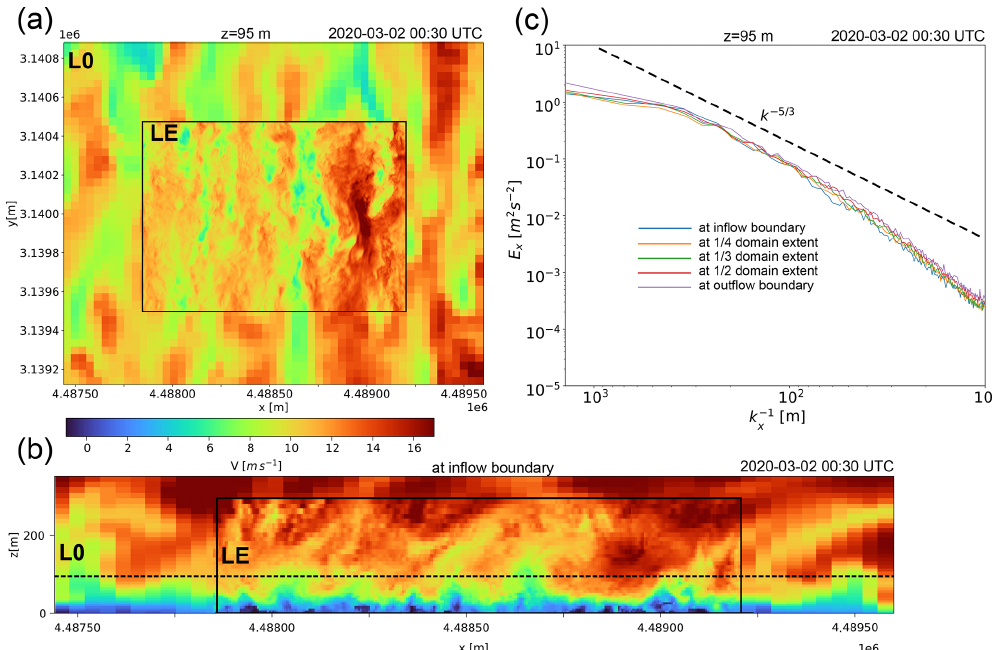
Figure 8. Depiction of a turbulent PBL flow simulated with the parent CAIRDIO domain L0 (40m) and the offline-nested sub-domain LE (5m) with a southern inflow boundary. In panel (a) the velocity component v is shown at 95m height. Small-scale turbulence extracted from domain LE is superimposed on the interpolated coarse-grid wind field at the boundary-ghost cells, resulting in well-resolved turbulent structures at the inflow boundary as shown in (b) for the vertical plane. The horizontal dashed line in (b) marks the position of the horizontal plane shown in (a) . In (c) , spectra of resolved turbulent kinetic energy are shown for the x axis at 95m height and 5m horizontal grid spacing. Plotted are, the energy spectra at various positions along the y